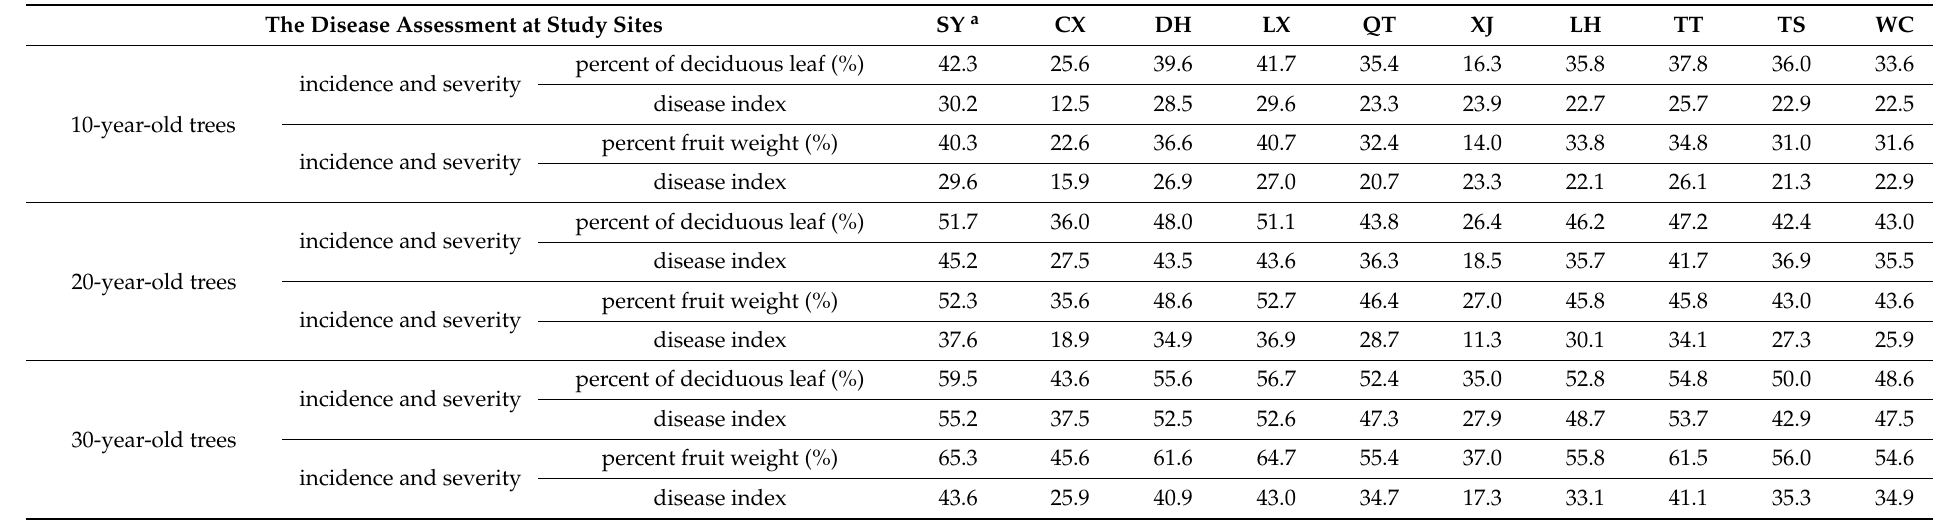
Table 1. Assessment of bayberry decline disease by incidence and disease index on leaves and single fruit weight. The Disease Assessment at Study